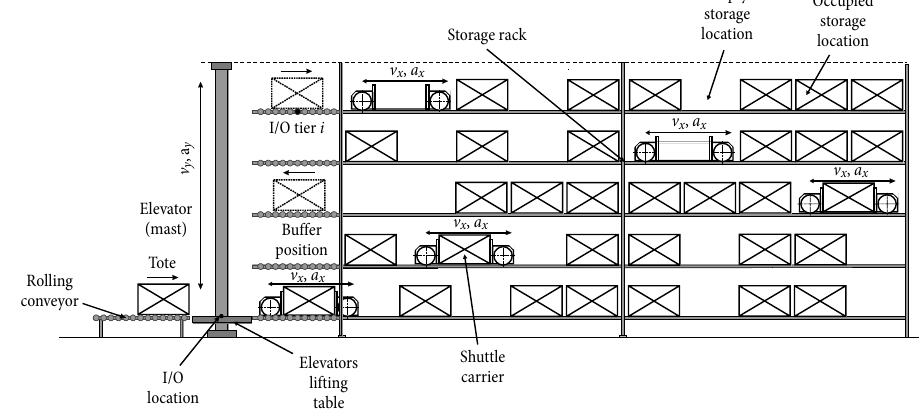
Fig. 1. SBS/RS (Lerher et al.